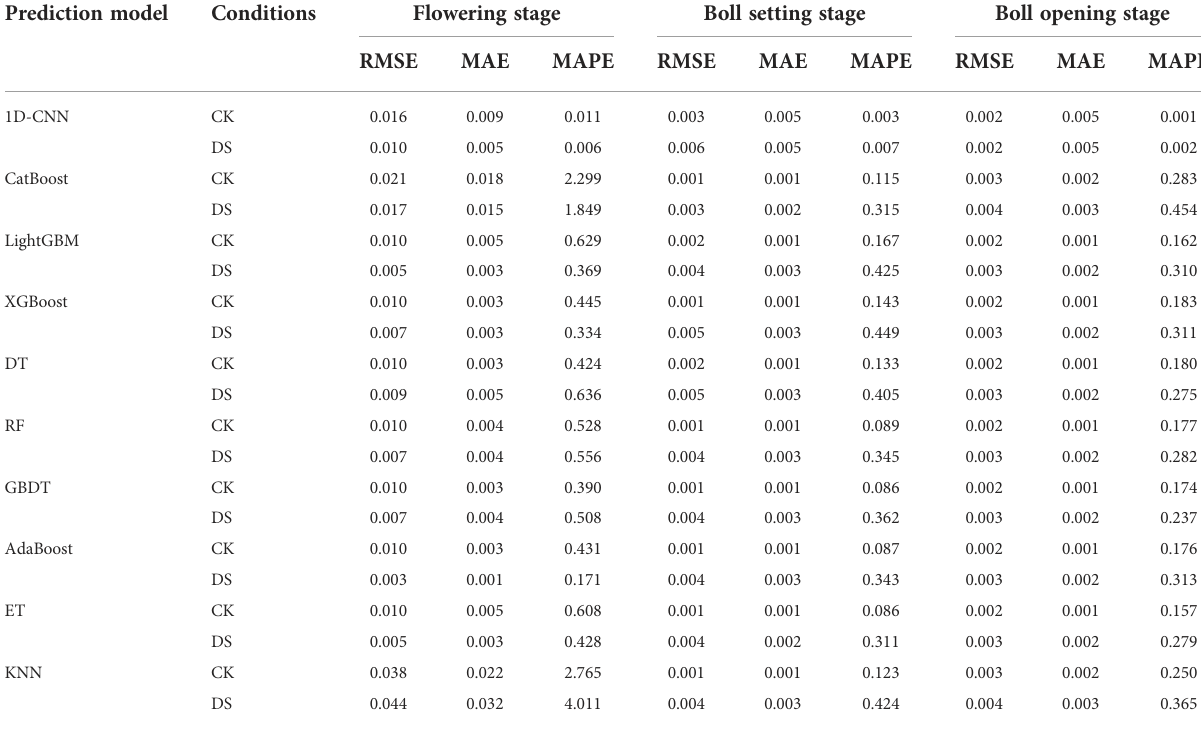
TABLE 1 Modeling of drought tolerance at different cotton growth stages with different prediction models. Prediction